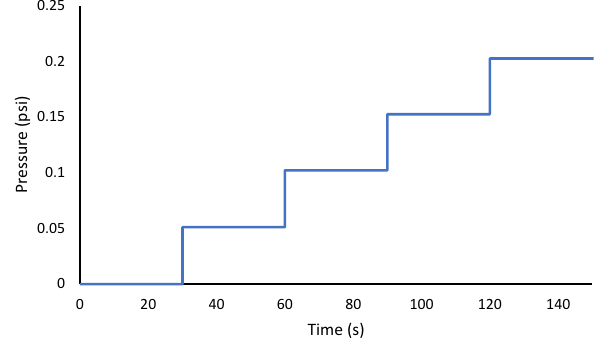
Fig. 6 Scratch test performed on 2-mm